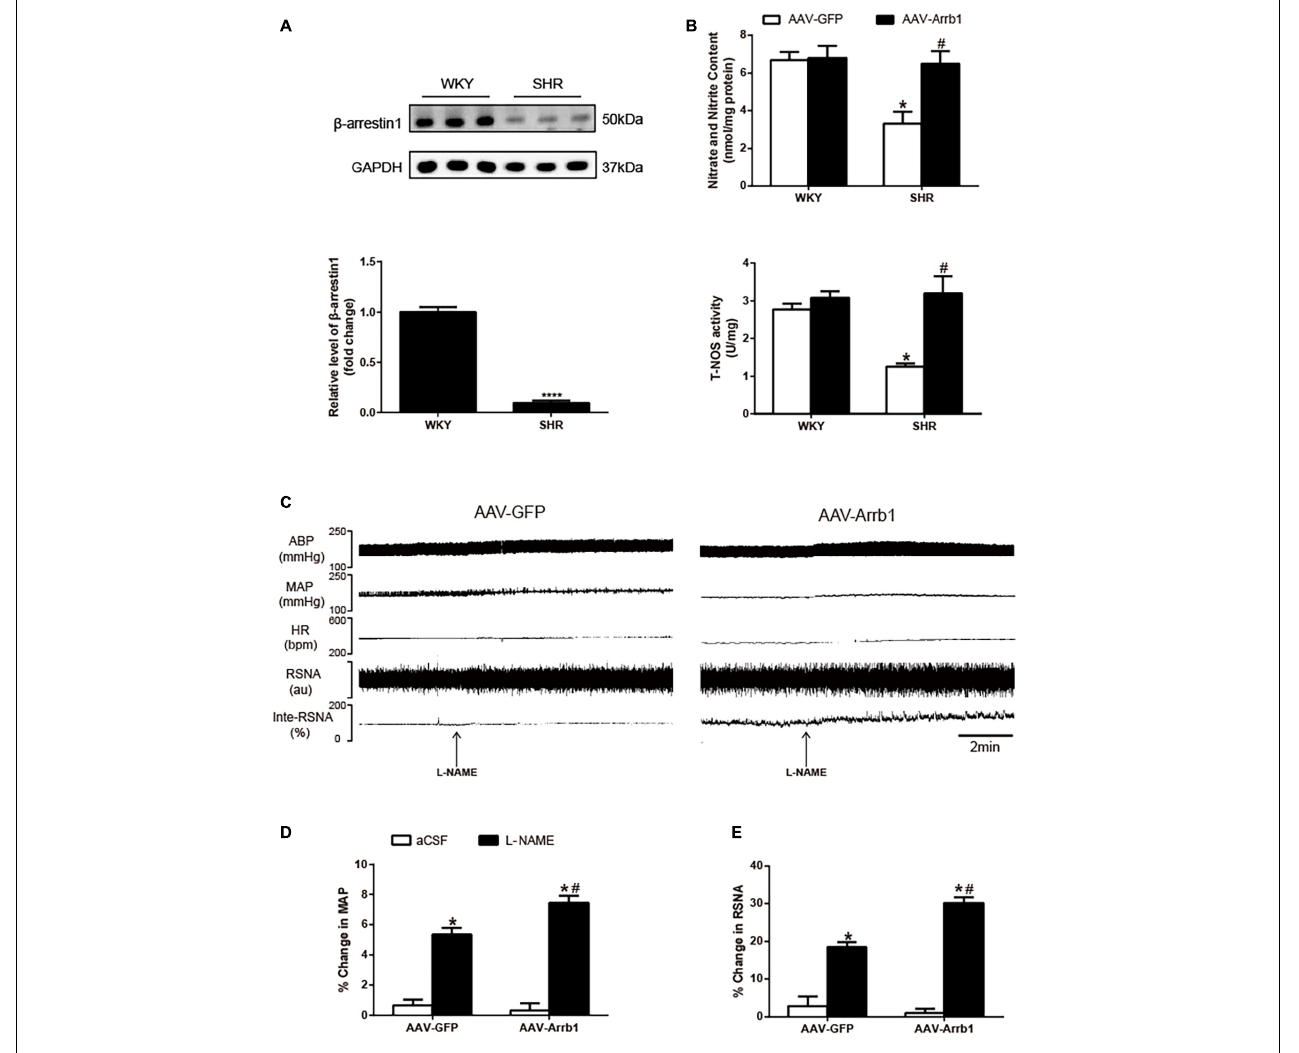
FIGURE 1 | Effects of overexpression of β -arrestin1 on NO production and NOS activity in the RVLM. Representative gel bands (top) and quantification data (bottom) of β -arrestin1 (A) . (B) Relative changes of nitrate and nitrite content (top) and total NOS activity (bottom) in the RVLM in response to administration of AAV-GFP and AAV-Arrb1 in WKY rats or SHRs. n = 6 per group in A and n = 5 per group in B. **** P < 0.0001, * P < 0.05 vs. WKY; # P < 0.05 vs. AAV-GFP. Original tracings (C) and quantification data (D,E) of BP, HR, and RSNA in response to unilateral microinjection of L -NAME (10 nmol) into the RVLM of SHRs pretreated with AAV transfection (AAV-GFP or AAV-Arrb1). n = 5 per group. * P < 0.05 vs. aCSF; # P < 0.05 vs. AAV-GFP. MAP, mean arterial pressure; NO, nitric oxide; NOS, nitric oxide synthase; RVLM, rostral ventrolateral medulla; AAV, adeno-associated virus; GFP, green fluorescent protein; WKY, Wistar-Kyoto; SHRs, spontaneously hypertensive rats; BP, blood pressure; HR, heart rate; RSNA, renal sympathetic nerve activity; L -NAME, N -nitro- L -arginine methyl ester; aCSF, artificial cerebrospinal fluid.